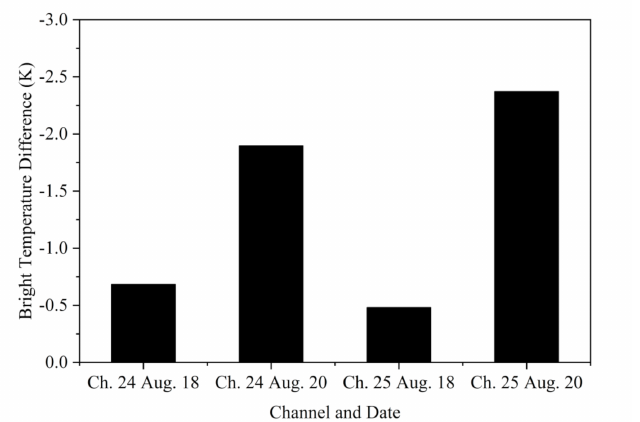
Figure 9. Validation results for the FY − 3D MERSI-II’s channel 24 and channel 25 for 18 August and 20 August.